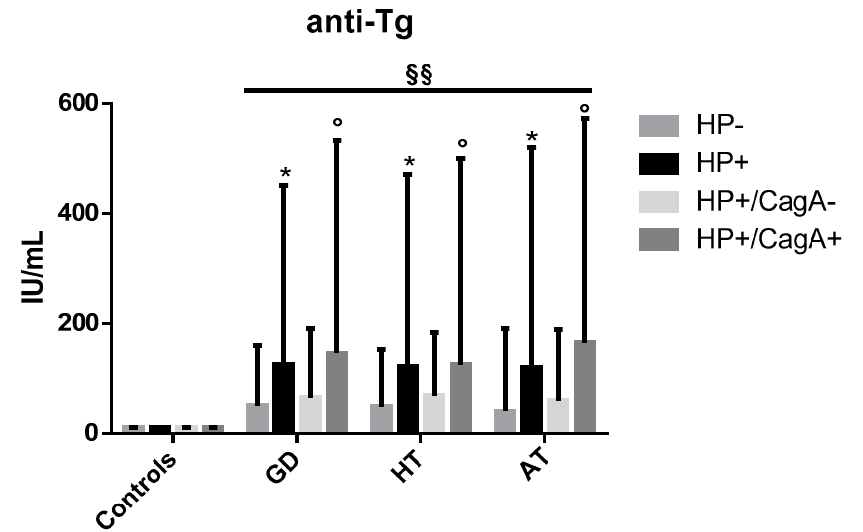
Figure 2. Median values (IQR) of anti-Tg serum antibodies in patients and controls according the overall H. pylori infectious and CagA status. * p < 0.05: HP+ vs. HP − patients, ° p < 0.05: HP+/CagA+ vs. HP+/CagA − patients, §§ p < 0.01 AITDs vs. no-AITD.